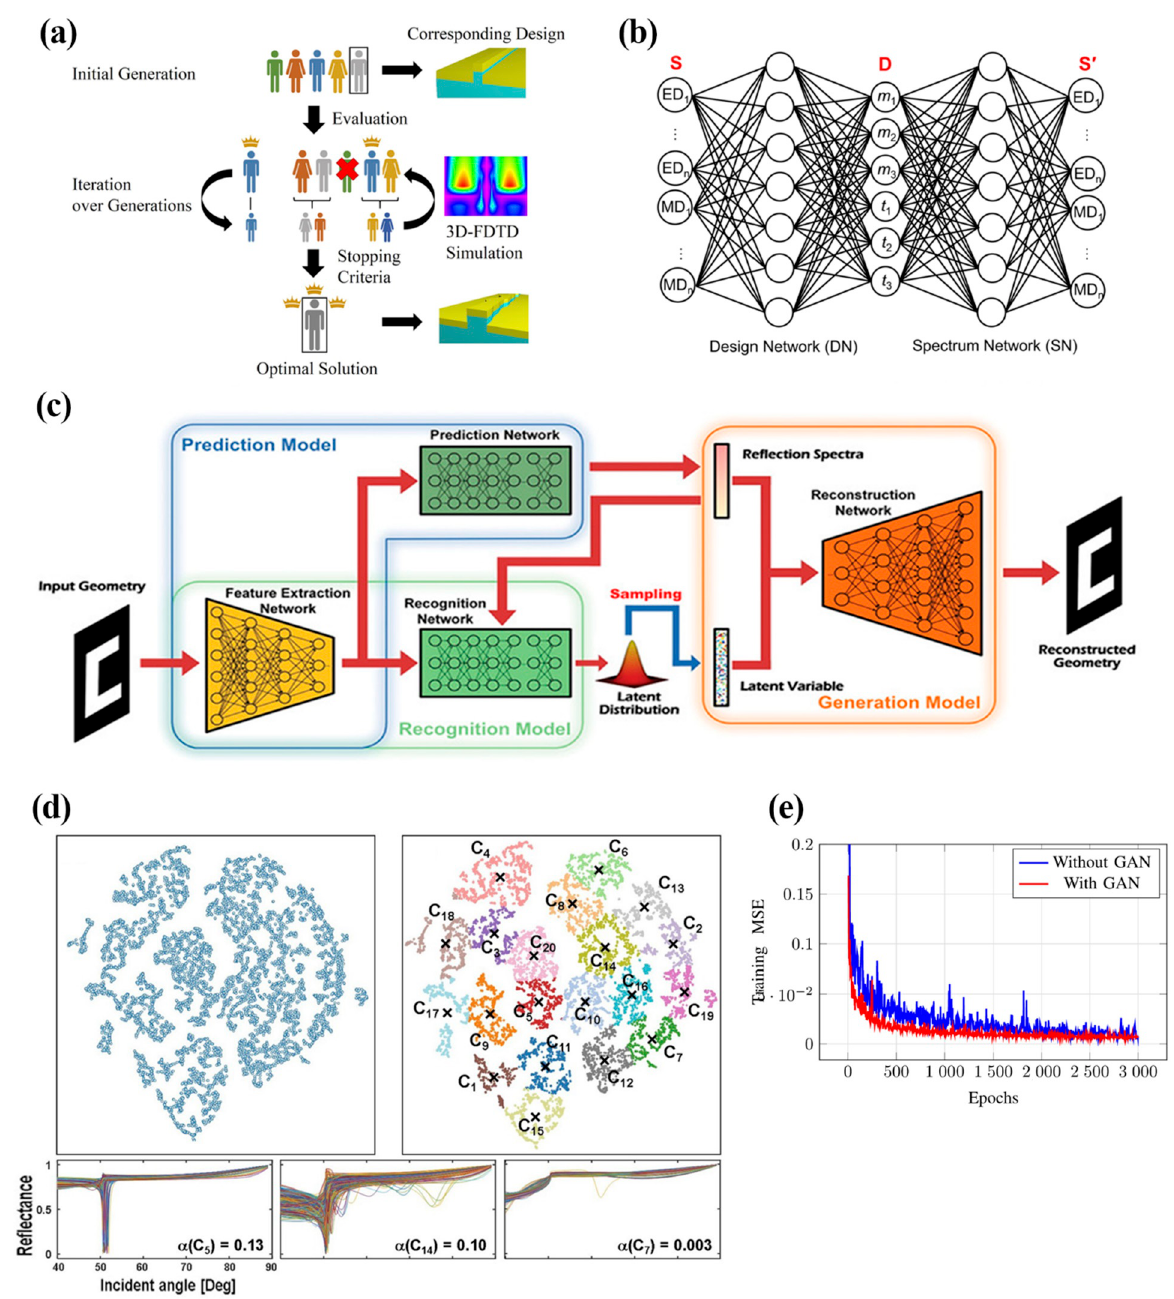
Figure 6. ( a ) Flow diagram of the micro-genetic algorithm with five initial candidates. Reproduced with permission from Ref. [98] . Copyright American Chemical Society (2018). ( b ) The inverse design network (DN) augmented with the forward spectrum network (SN) which generates feedback to improve the performance of DN. Reproduced with permission from Ref. [57]. Copyright American Chemical Society (2019). ( c ) The general structure of the networks designed for property prediction, pattern recognition, and generation. The generative network requires spectrum data and the latent variable as input to generate topology designs. Reproduced with permission from Ref. [99]. Copyright John Wiley and Sons (2019). ( d ) K-means clustering on 2D distributed data (result of dimension reduction). Bottom diagrams show the common characteristics (reflectance) of some clusters (C5, C14, C7). Reproduced with permission from Ref. [100] . Copyright Elsevier (2020). ( e ) Performance comparison between GAN-augmented ANN and regular ANN with a lean dataset. The training Mean Squared Error of GAN-augmented ANN is comparatively small and stable. Re- produced with permission from Ref. [66]. Copyright IEEE (2021).